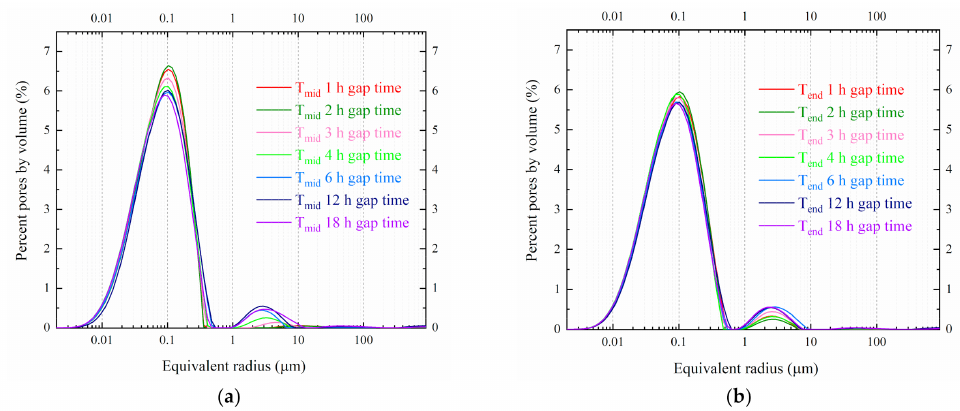
Figure 12. ( a , b ) PSD at different freezing gap